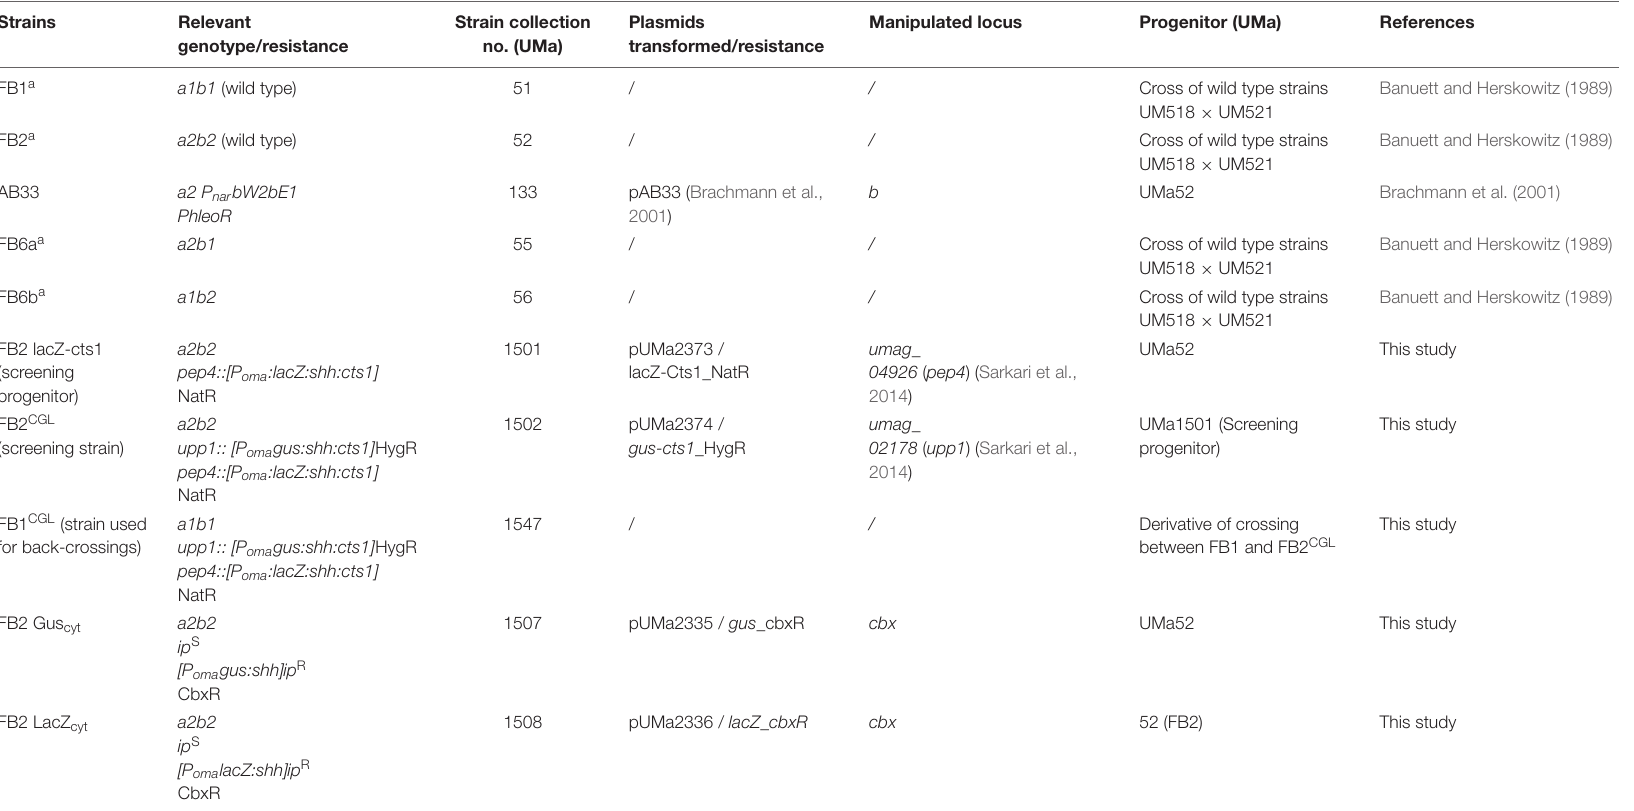
TABLE 1 | U. maydis strains used in this study. Strains Relevant genotype/resistance